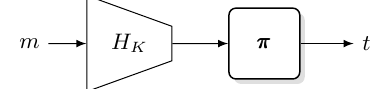
Figure 2.1: The Hash-then-RP paradigm.